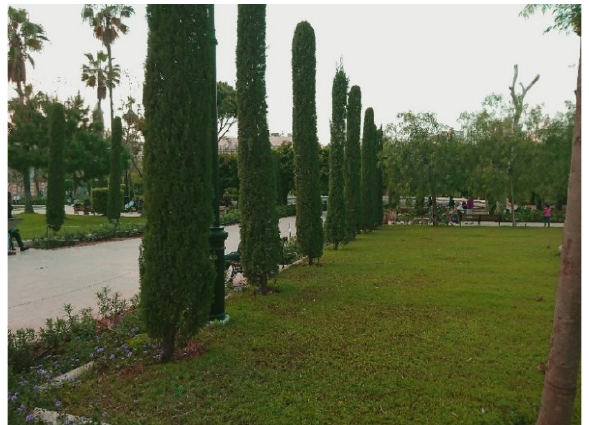
Figure 5. The René Mouawad garden, Sanayeh area, Beirut (adapted from Maria A. El Helou photo archive)